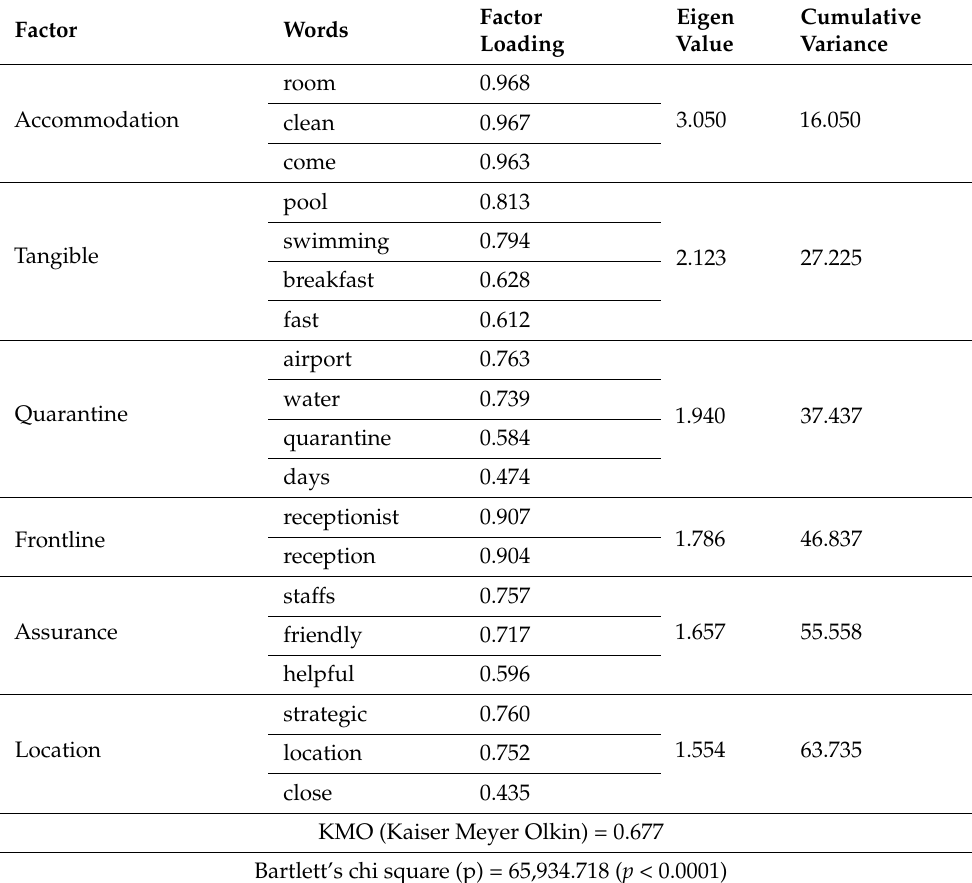
Table 7. Result of the factor